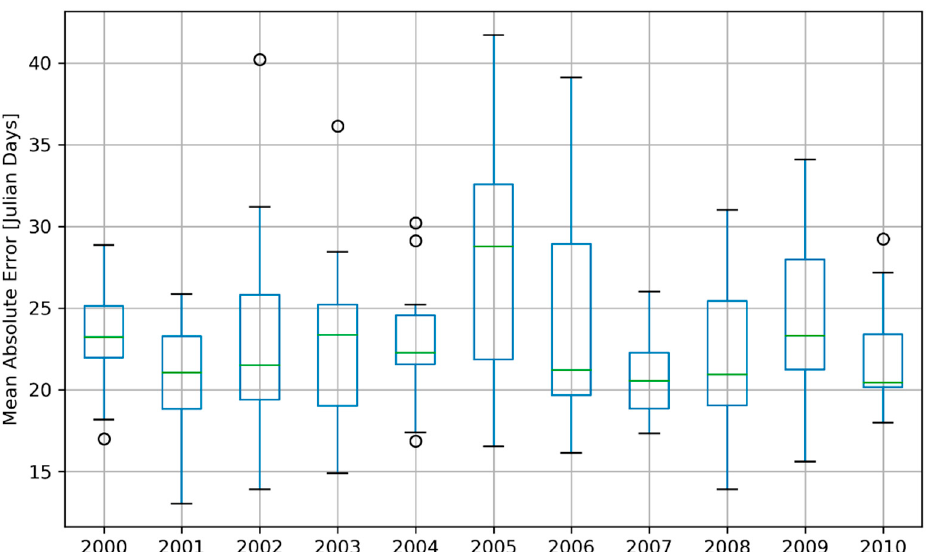
Figure 6. Spatial verification of ORS fields based on the mean absolute error (Julian days). The calculation was performed for each of the 15 SYS4 ensemble members (initialized in February) compared to CHIRPS for the entire study region. The box extends from the quartile values Q1 to Q3 of the data, with a line at the median (Q2). The position of the whiskers shows 1.5 × interquartile range (Q3–Q1) from the edges of the boxes. Outliers extend beyond the end of the whiskers.